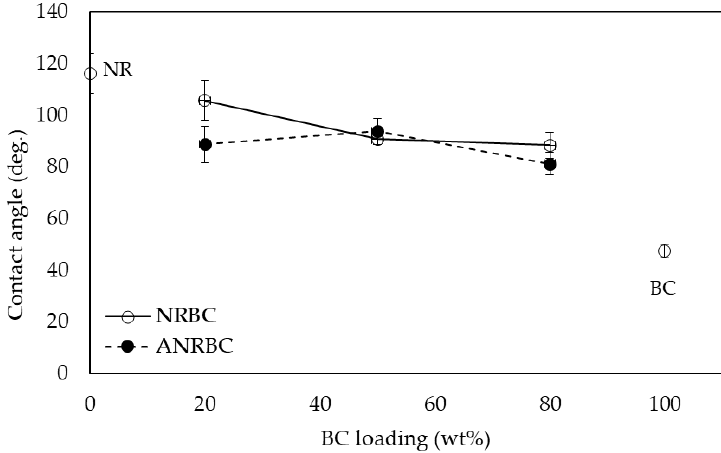
Figure 4. The static water contact angle of NR, BC, NRBC, and ANRBC films. The values are expressed as mean ± SD (n =